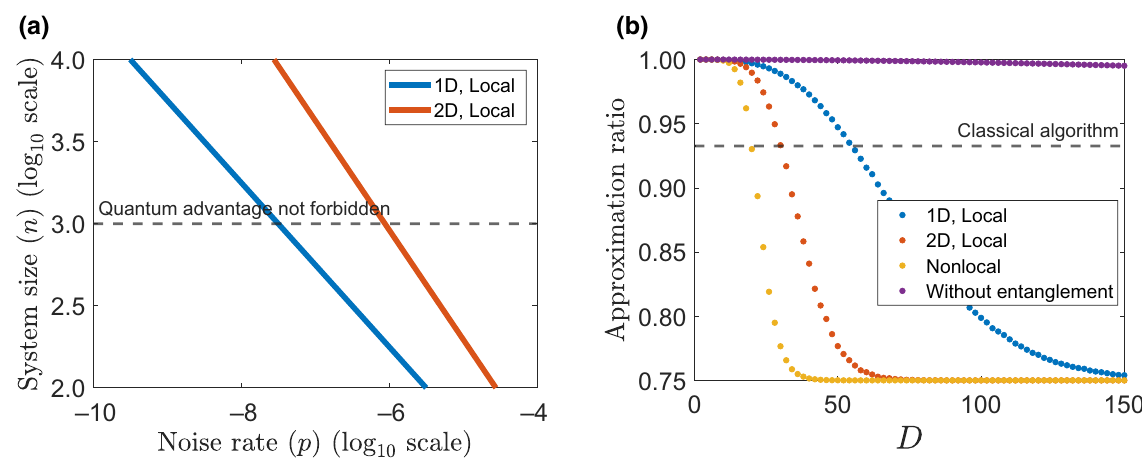
FIG. 4. In (a) we represent the relation between the system size and the error rate when the average number of depolarized qubits at the end of the computation is fixed to (cid:13) q (cid:2) / n = 0.5 for bounded degree-( (cid:11) = 3) graphs. In the 1D case the depth is D 1D = 30 n , and in √ 7 n . The horizontal dashed line corresponds to system sizes of n = 1000, which is when a potential quantum the 2D case D 2D = 10 advantage could begin to be practically useful [26]. In (b) we represent the upper bound for the approximation ratio of bounded degree- ( (cid:11) = 3) graphs, given by Eq. (17), as a function of the circuit depth for the different architectures: 1D, 2D, and nonlocal. We use a system size n = 900 and an error rate p = 10 − 3 . The horizontal line represents the approximation ratio that is reachable by an efficient classical algorithm. The number of samples taken is 2000, which reduces the error in the estimated mean to